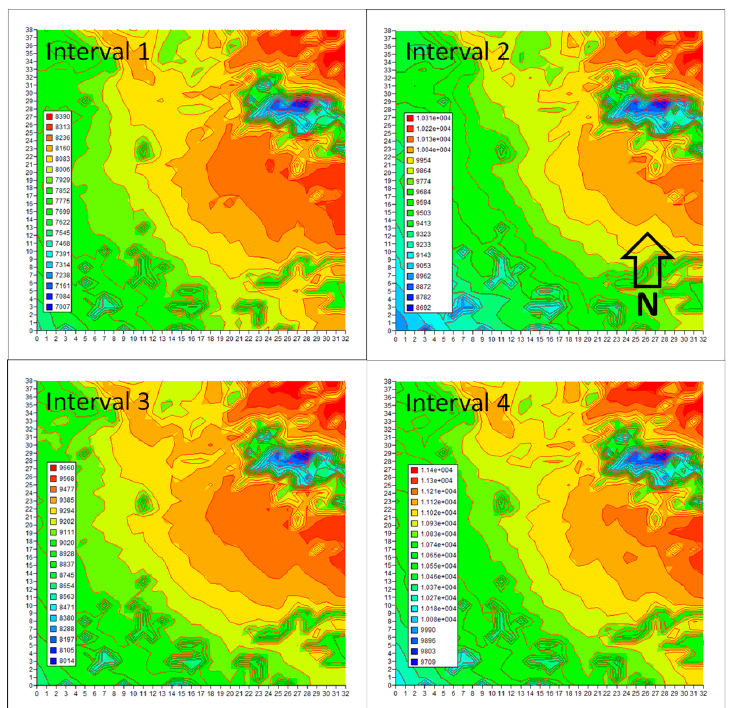
Figure 6. Modeled total degree-hours (DH) for intervals 1–4 in the downtown area. The derived interval-average temperature (computed as DH/hour), blue to red, is as follows: 17.2–20.6 ◦ C for interval 1; 21.3–25.3 ◦ C for interval 2; 19.6–23.7 ◦ C for interval 3; and 22.5–27.9 ◦ C for interval 4.